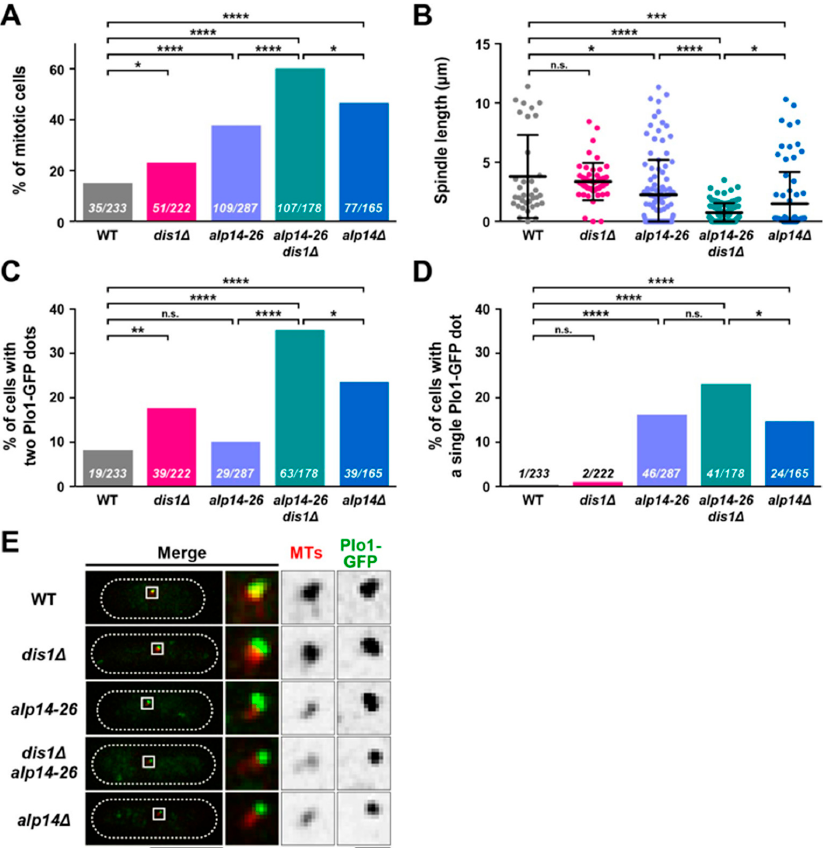
Figure 2. Alp14 and Dis1 collaborate to regulate proper mitotic progression. Exponentially growing cells at 27 ◦ C were shifted to 36 ◦ C for 2 h. Spindle MTs (mCherry-Atb2, red) and mitotic SPBs (Plo1-GFP, green) were visualised. ( A ) Mitotic indices. Mitotic cells were identified as those containing